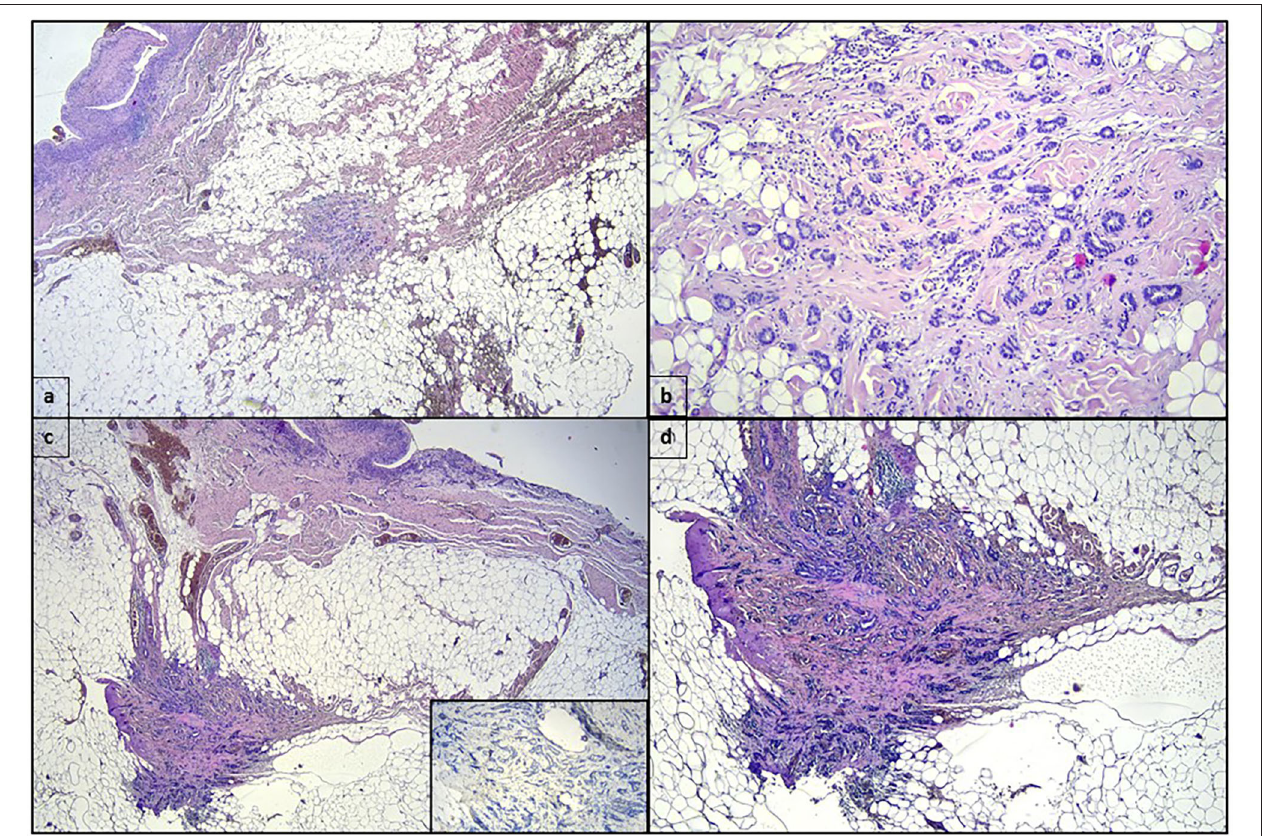
FIGURE 2 | (a) One mm-wide invasive ductal carcinoma in the fibroadipose tissue surrounding the periprosthetic capsule, whose inner surface can be recognized in the upper left of the panel (hematoxylin eosin, original magnification 2 × ). (b) Higher magnification highlights the invasive ductal carcinoma shown in (a)